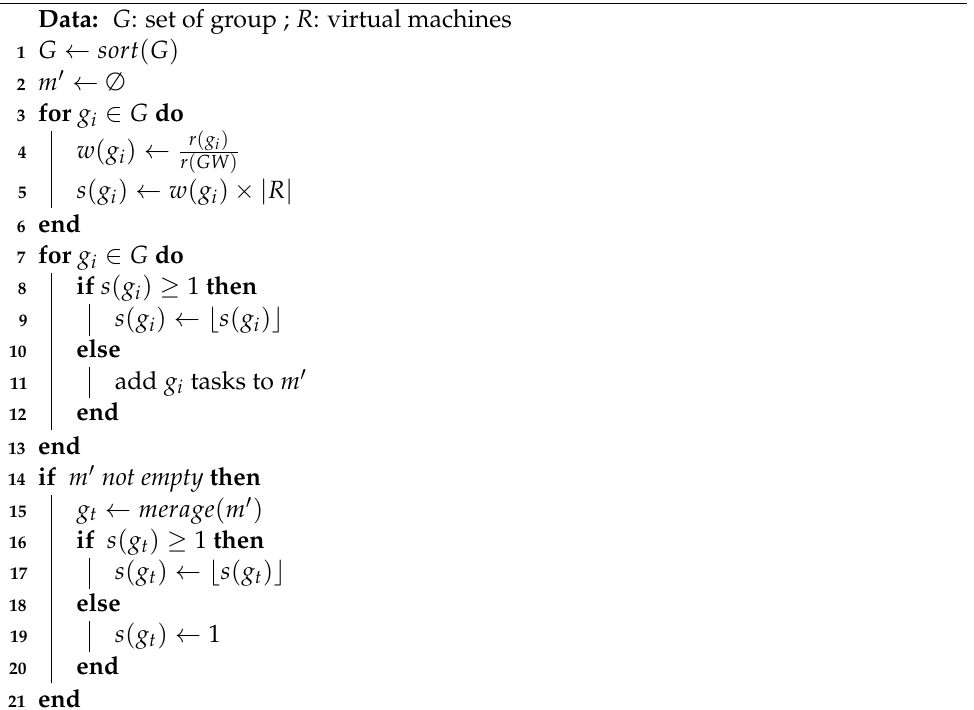
Algorithm 4: Resource